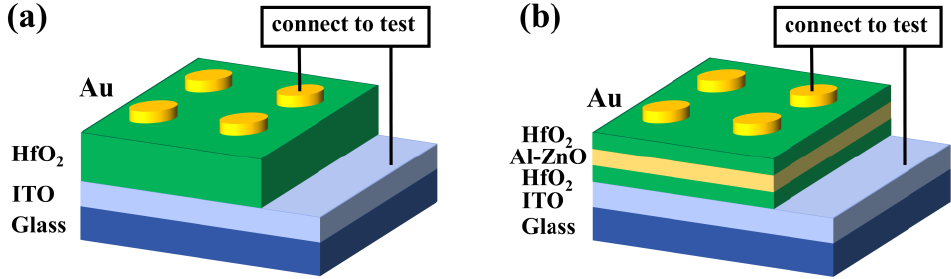
Figure 1. ( a ) Structure of Au/HfO 2 /ITO device and ( b ) Au/HfO 2 /Al-ZnO/HfO 2 /ITO